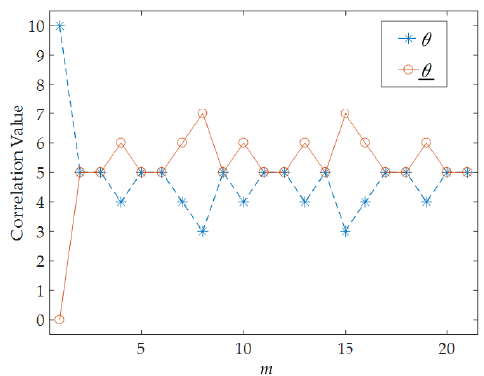
Figure 2. The correlation values and the complementary correlation values of CMLS C (1,1) (21) .